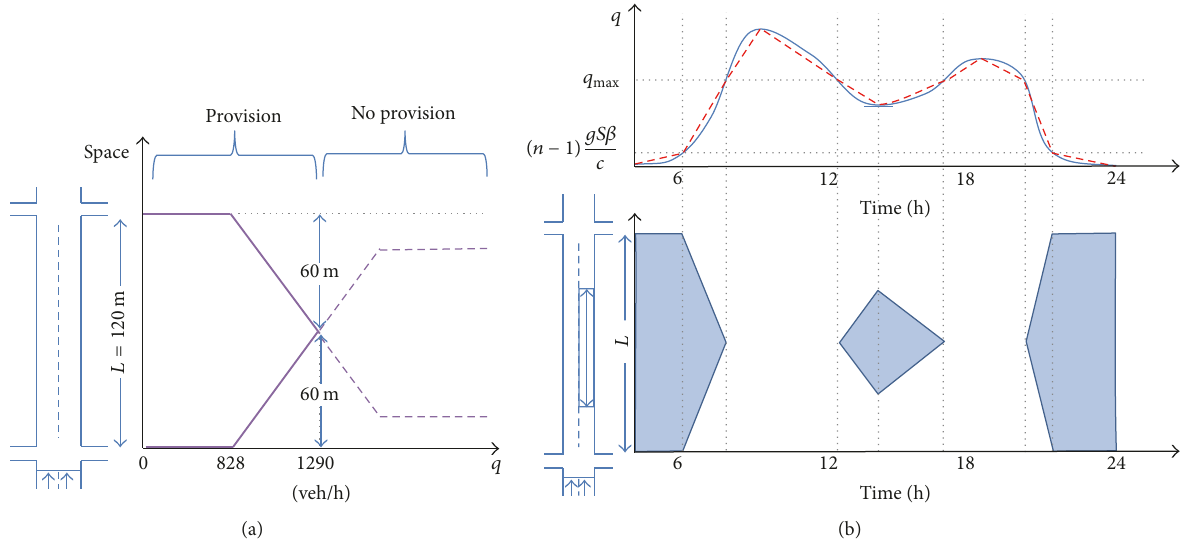
Figure 6: (a) Values of 𝑑 1 and 𝑑 2 in relation to the traffic demand volume 𝑞 . (b) Dynamic delivery area variations across the day.